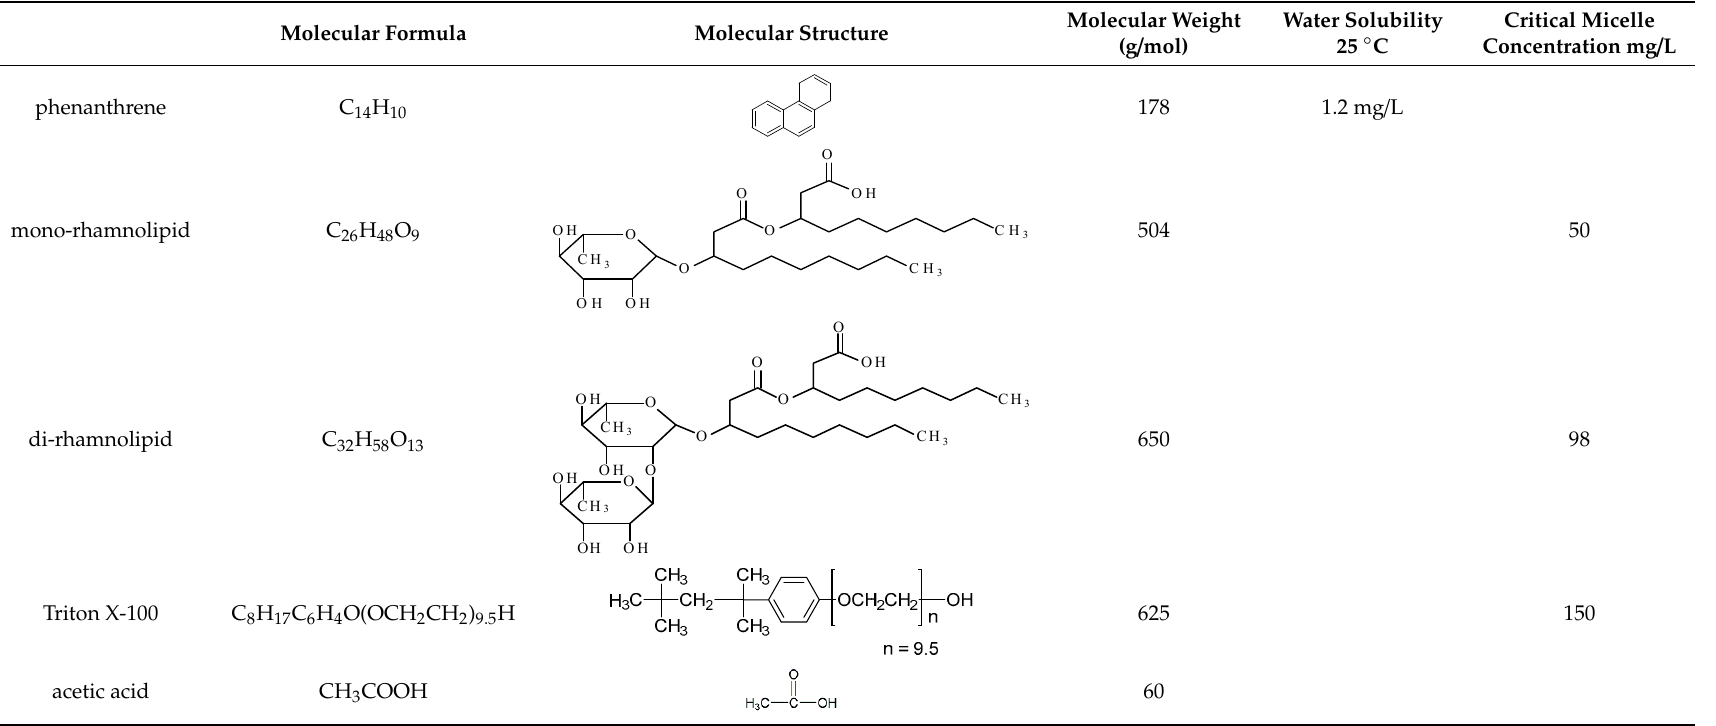
Table 1. Selected properties of substances in this study.